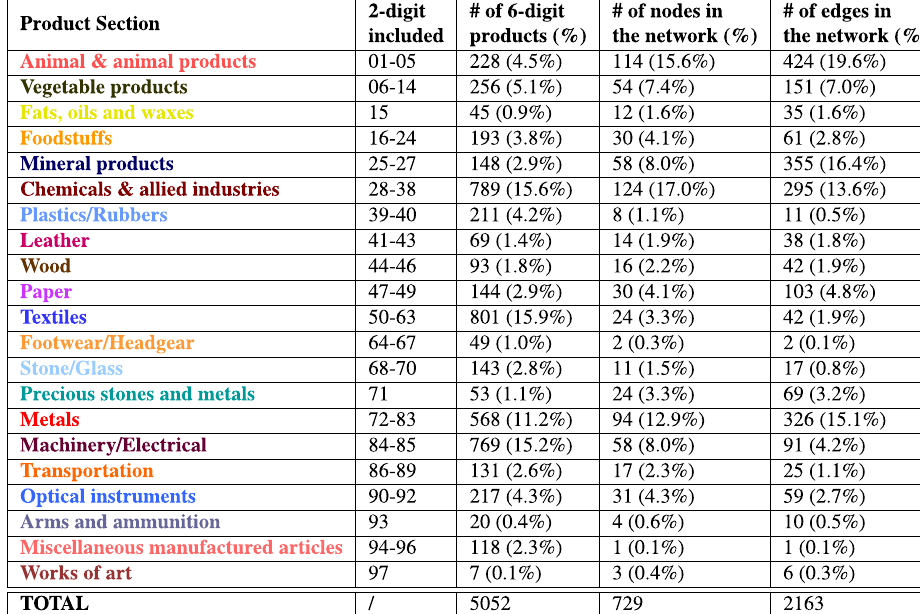
st column: product section names; 2